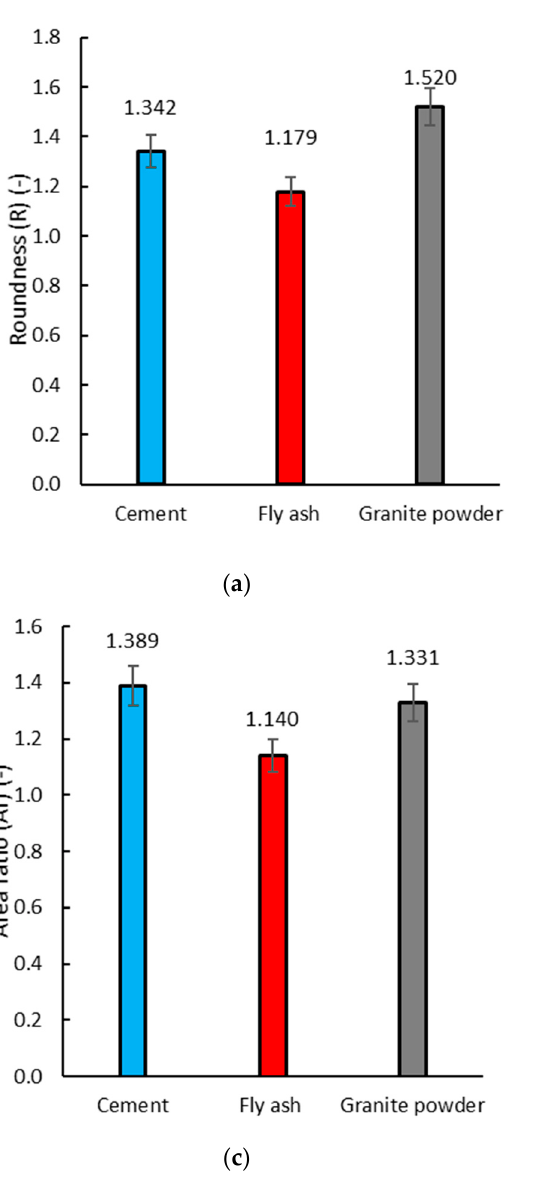
Figure 5. Morphological analysis of the grains of the binders: ( a ) the area ratio ( Ar ), ( b ) the aspect ratio ( AR ), ( c ) roundness ( R ), and ( d ) the specific surface area (Blaine).